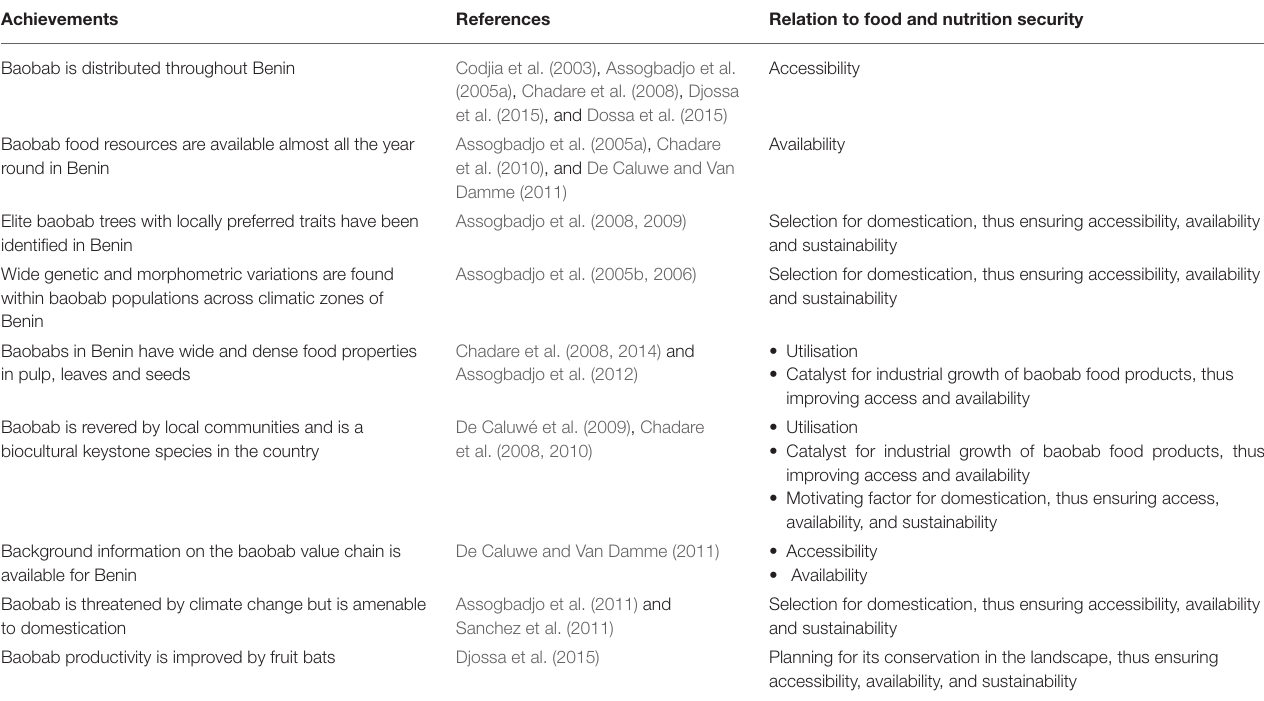
TABLE 1 | Summary of achievements on baobab based on research findings and their relationship with food security